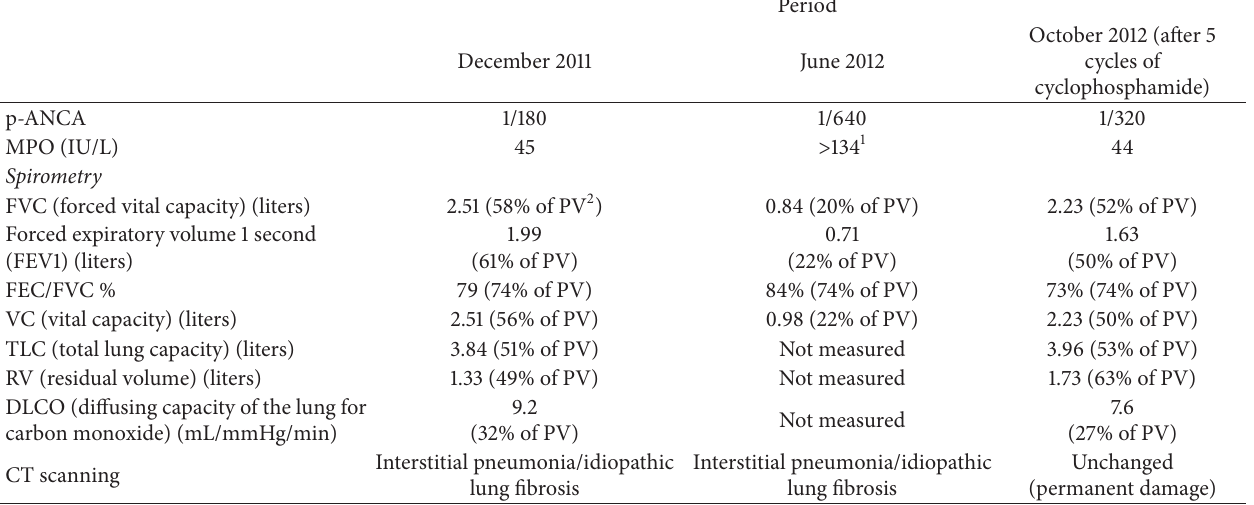
Table 1: Change of p-ANCA, MPO, spirometry, and CT scanning characteristics in the period from December 2011 to October 2012.